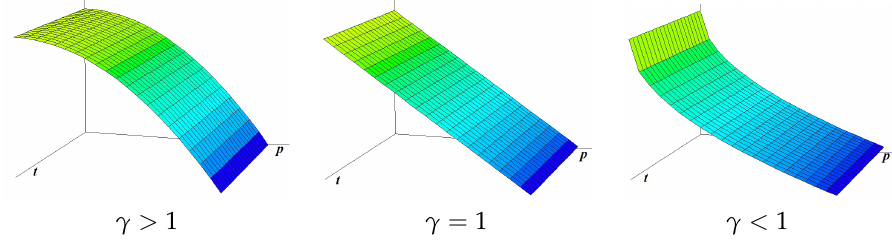
Figure 2. Demand functions D ( t , p ) when n = 1.